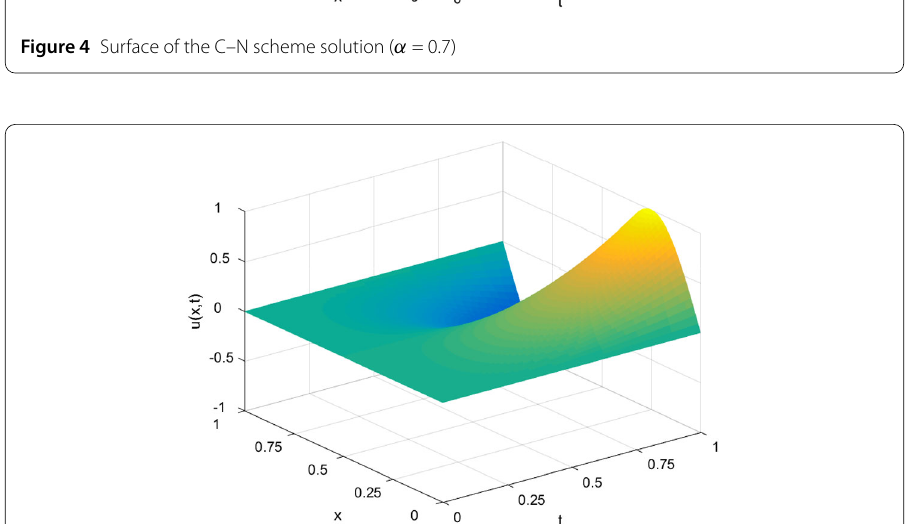
Figure 5 Surface of the IASC–N scheme solution ( α = 0.7)